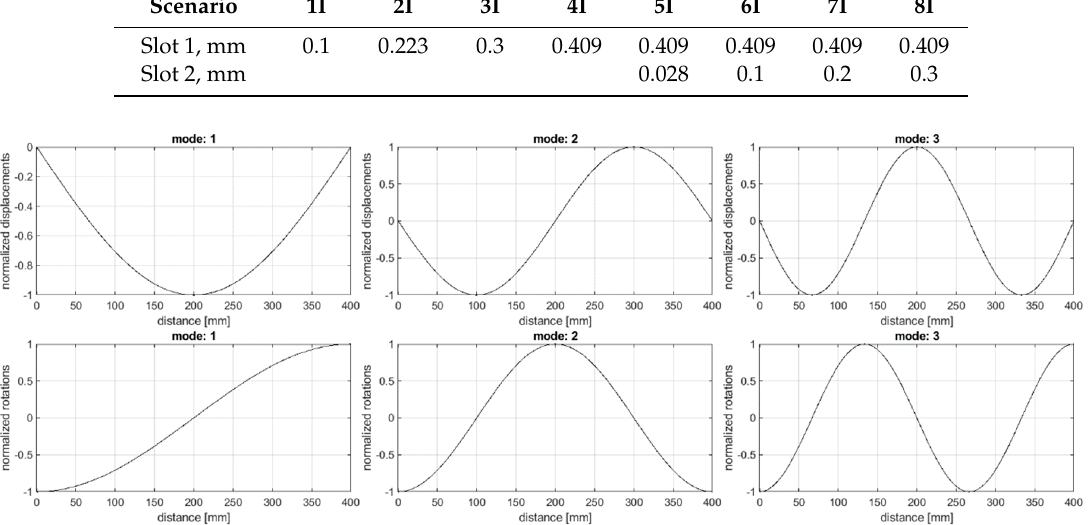
Figure 3. Displacements and rotations for the investigated modes.